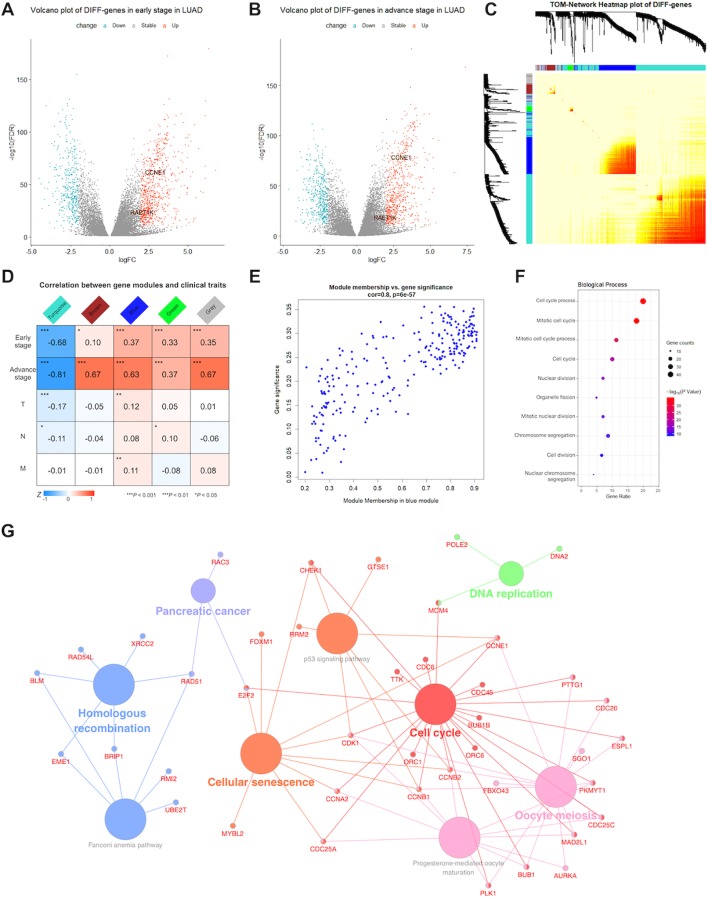
Detection of significant genes and their function related to lung adenocarcinoma (LUAD). Volcano plots showed fold change (FC) and P-values of differentially expressed genes in early (A) and advance (B) stage LUAD versus normal samples. Blue nodes present significantly down-regulated, and red nodes are up-regulated expressed genes. Grey nodes are not differentially expressed. RAET1K and CCNE1 expression are annotated. (C) In middle topological overlap matrix (TOM) heatmap, every row and column present one gene, light color presents low, while darker red presents higher weighted correlation. The dynamic tree cluster dendrogram of DIFF-genes are showed in the left and top, gray square indicates genes that are involved in any known module. (D) LUAD module-clinical feature relationships. The row matches a clinical trait (early stage, advance stage, T for tumor size, N for lymph node and M for metastasis) and the column matches a genes module. Correlation of module and clinical trait is showed in each cell. The darker the color is, the higher the degree of correlation is. Red presents positive, while blue presents negative correlation. (E) Scatterplot of gene significance and module membership in the blue module. Correlation coefficients and P-values are at the top. (F) Bubble plots showed top 10 terms of gene ontology (GO) enrichment analysis in biological process for blue module. The Y-axis correspond to the GO terms. The gene counts and -log (enrichment P-value) in every GO term were proportional to the area and color of the bubble, respectively. (G) Genes Kyoto Encyclopedia of Genes and Genomes (KEGG) enrichment analysis in blue module. The small size nodes in the network represent the genes enriched in the specific pathway, the big size nodes represent pathway term. The node colors correspond to the ClueGO-determined KEGG pathway clusters.